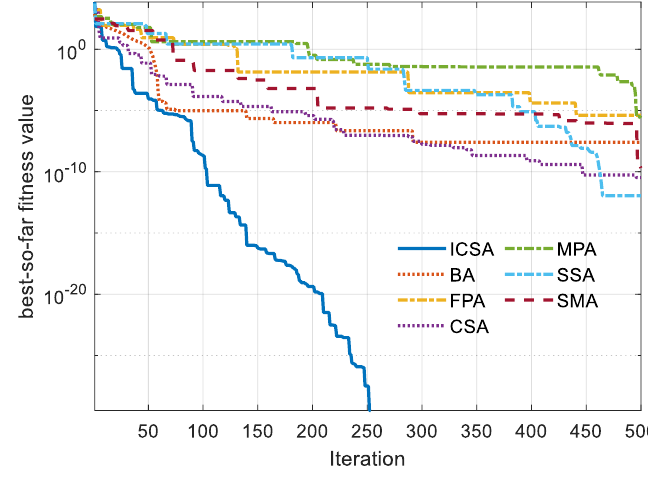
Figure 6. Convergence curve for F5.